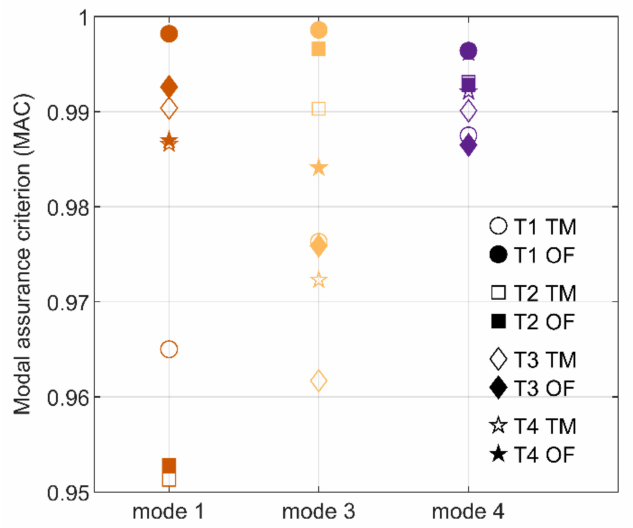
Figure 14. Modal assurance criterion (MAC) for all